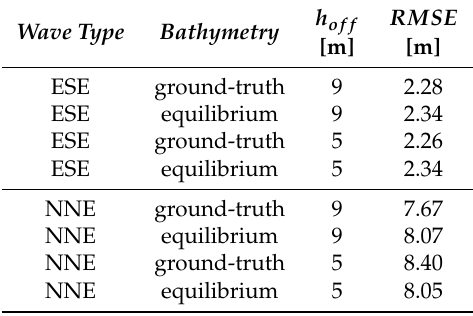
Table 3. RMSE of the x s , max of the flood simulations with respect to the x s , max of the corresponding baseline